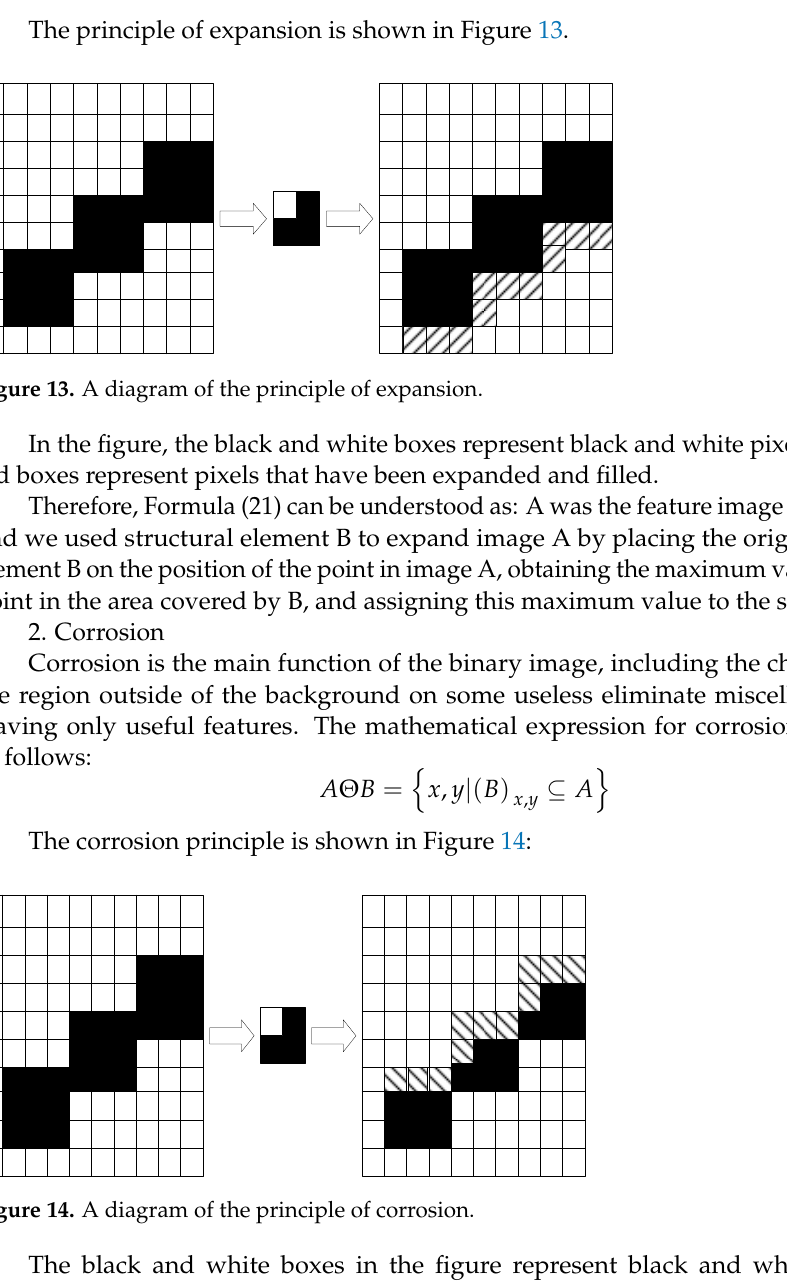
13 of 22 Figure 12. A flow chart for the adaptive log-Gabor function. 3.3. Defect-Type Detection After feature extraction, binary images often still have some subtle miscellaneous points, and sometimes the edge information is not coherent enough, which will affect the accuracy of type judgment. To filter out the clutter and make the edge information smooth